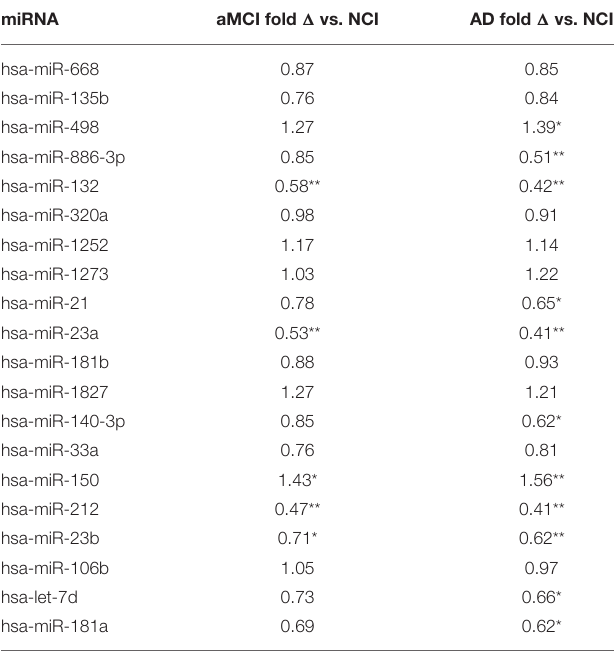
TABLE 3 | qPCR analysis of select miRNAs in frontal cortex of NCI, aMCI, and AD subjects. miRNA aMCI fold 1 vs. NCI AD fold 1 vs.